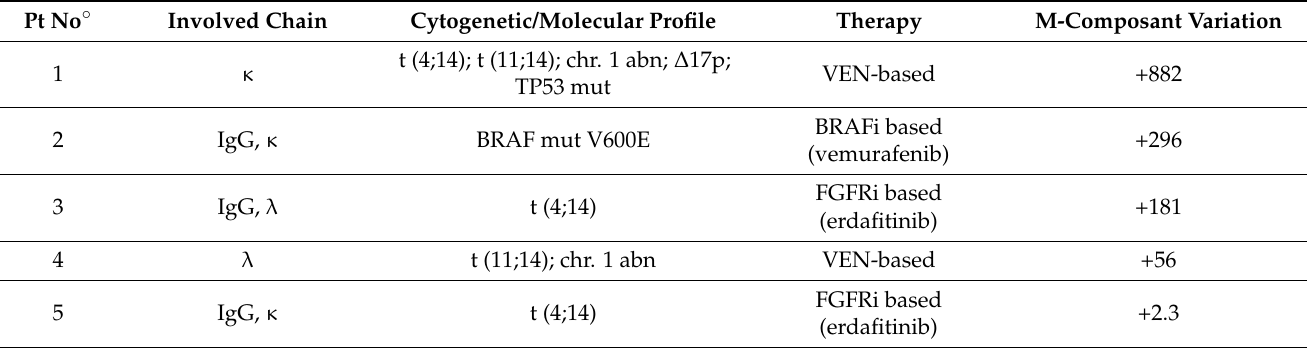
Table 3. Details of molecular-oriented patients correlating with response